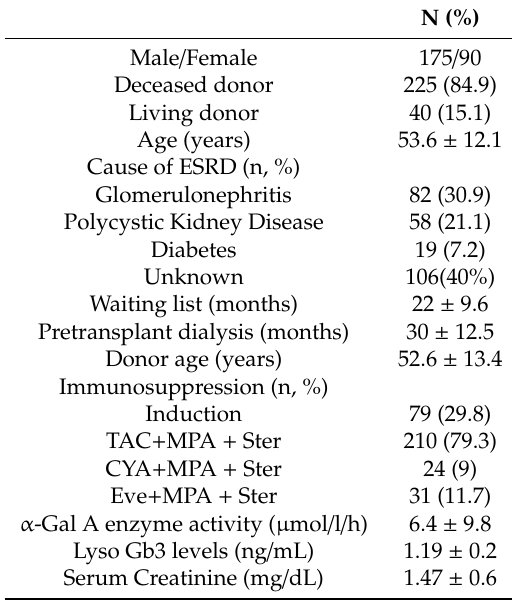
Table 1. Clinical characteristics of the study group (265 kidney transplant